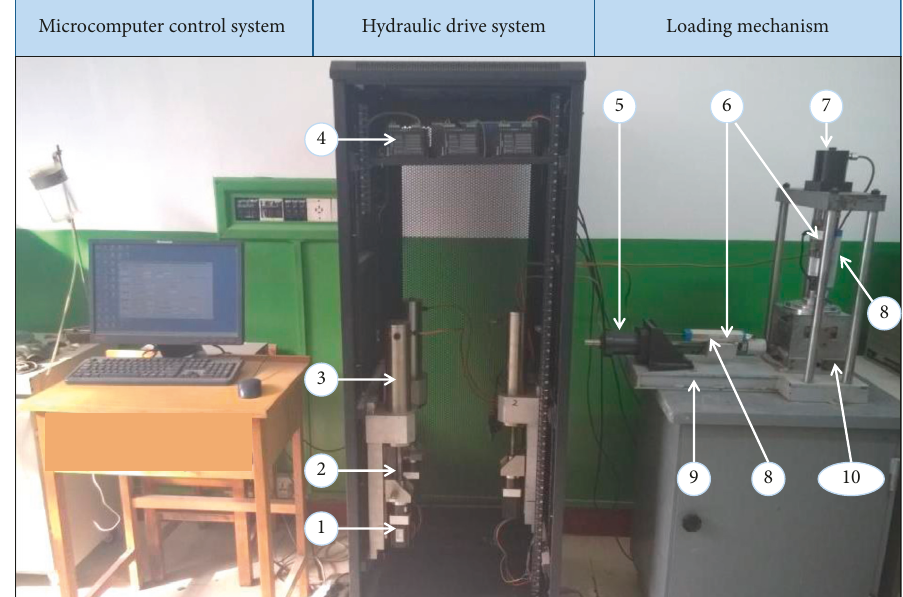
Figure 1: Components of XCSSA: step-servo motor (1), ball screw (2), hydraulic cylinder (3), single-chip microcomputer (4), horizontally- loading hydraulic cylinder (5), pressure transducer (6), vertically loading hydraulic cylinder (7), displacement transducer (8), reaction base (9), and pressure cell (10).